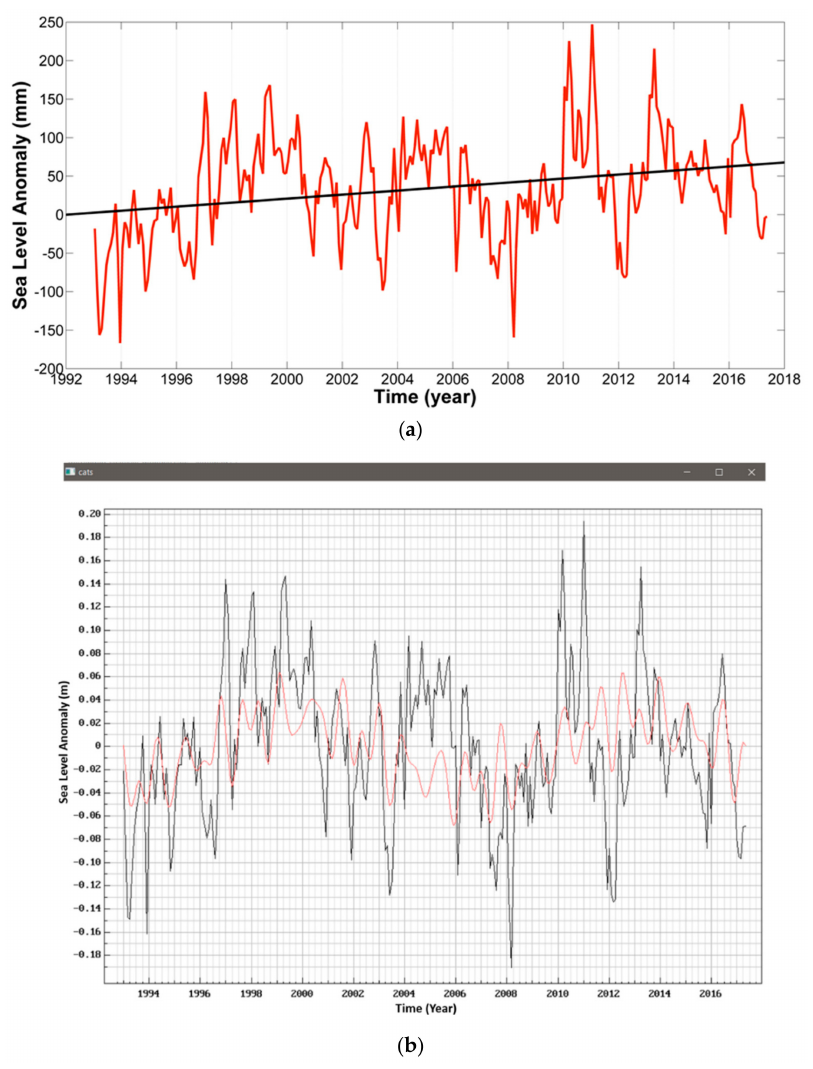
Figure 5. Monthly sea level time series in the Black Sea from 1993 to 2017 from the satellite altimetry data: ( a ) Non-seasonal sea level time series with its linear fitting. ( b ) Dominant cycles (red) over the detrended and non-seasonal sea level time series